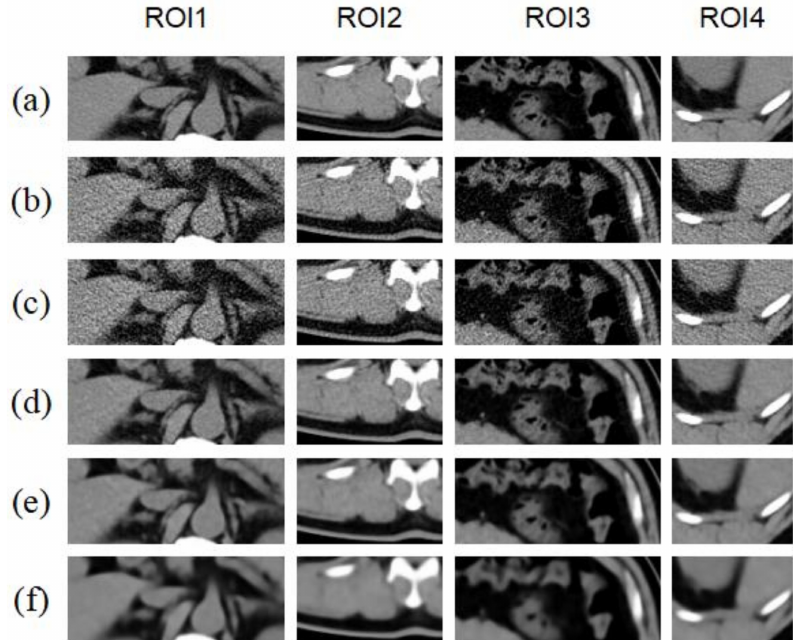
Figure 6. Images ( a – f ) show zoomed images of the portions marked with red squares in Figure 5a, providing more detail of the differences in reconstructed image quality under different iterations.